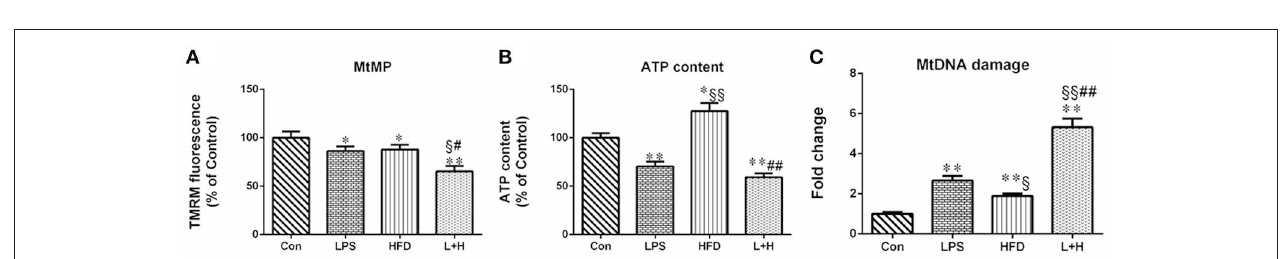
FIGURE 5 | Hepatic gene expression related to lipid metabolism and other related pathways in 8-week-old offspring rats. (A) Differentially expressed genes between the control and LPS groups. Differentially expressed genes detected by RT-PCR array. A 2-fold difference and p value = 0.05 were marked as vertical and horizontal lines, respectively. n = 3 in each group. mRNA expressions of Tm7sf2 (B) and VLDLR (C) in the livers of offspring rats. The data are presented as the mean ± SEM. n = 6 in each group. ** P < 0.01 vs. control, § P < 0.05, §§ P < 0.01 vs. LPS group, # P < 0.05 vs. HFD group (One-way ANOVA). Tm7sf2, transmembrane 7 superfamily member 2; VLDLR, very low density lipoprotein receptor. Con group, male offspring rats treated with prenatal saline and postnatal normal diet from 4 to 8 weeks old; LPS group, male offspring rats treated with prenatal LPS and postnatal normal diet from 4 to 8 weeks old; HFD group, male offspring rats treated with prenatal saline and postnatal high fat diet from 4 to 8 weeks old; L + H group, male offspring rats treated with prenatal LPS and postnatal high fat diet from 4 to 8 weeks old.